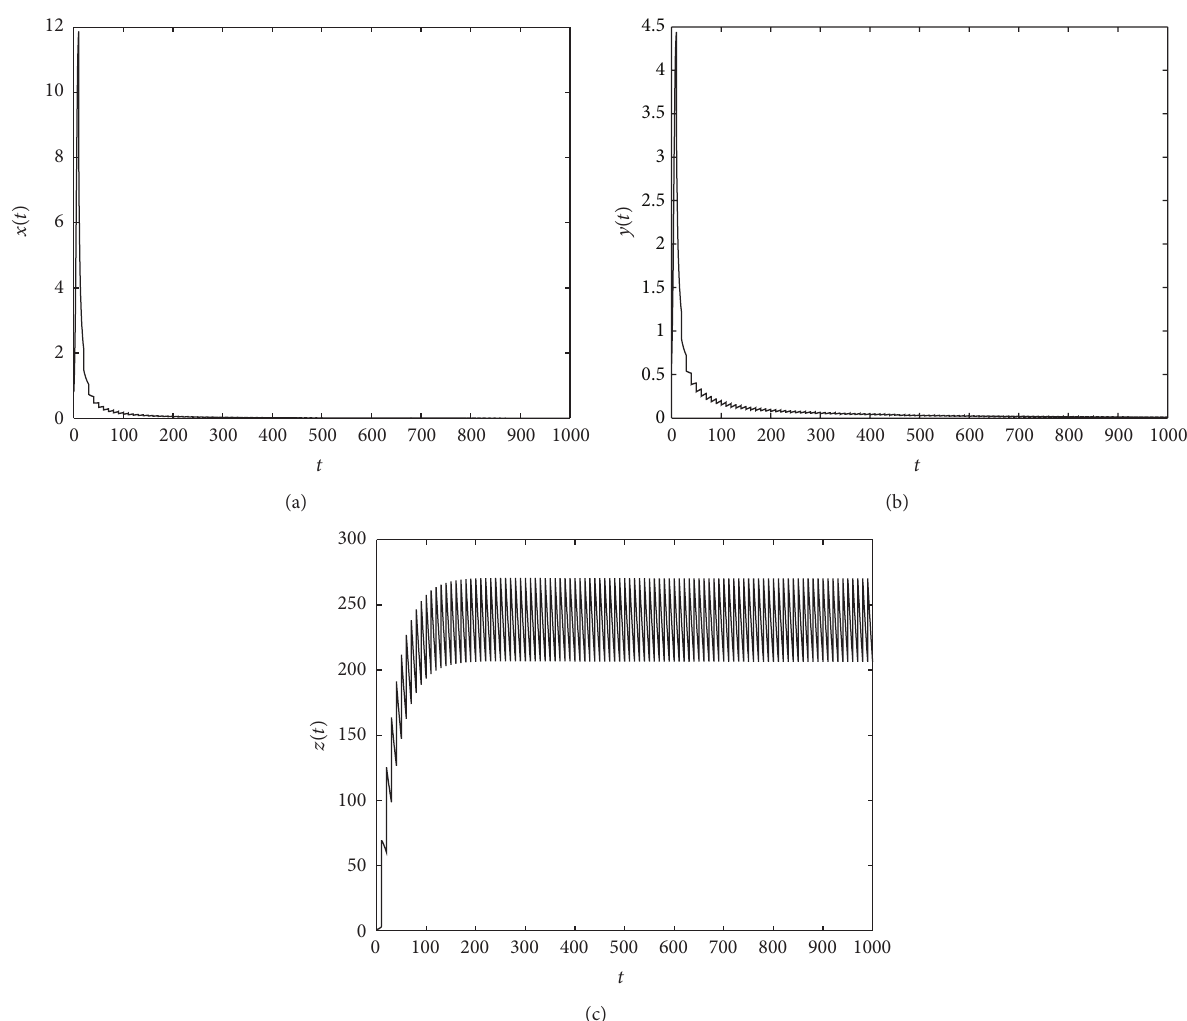
Figure 1: Time series of a solution of model (6) with 𝑞 = 3.9 : (a) time series of the prey population 𝑥(𝑡) ; (b) time series of the prey population 𝑦(𝑡) ; (c) time series of the predator population 𝑧(𝑡)